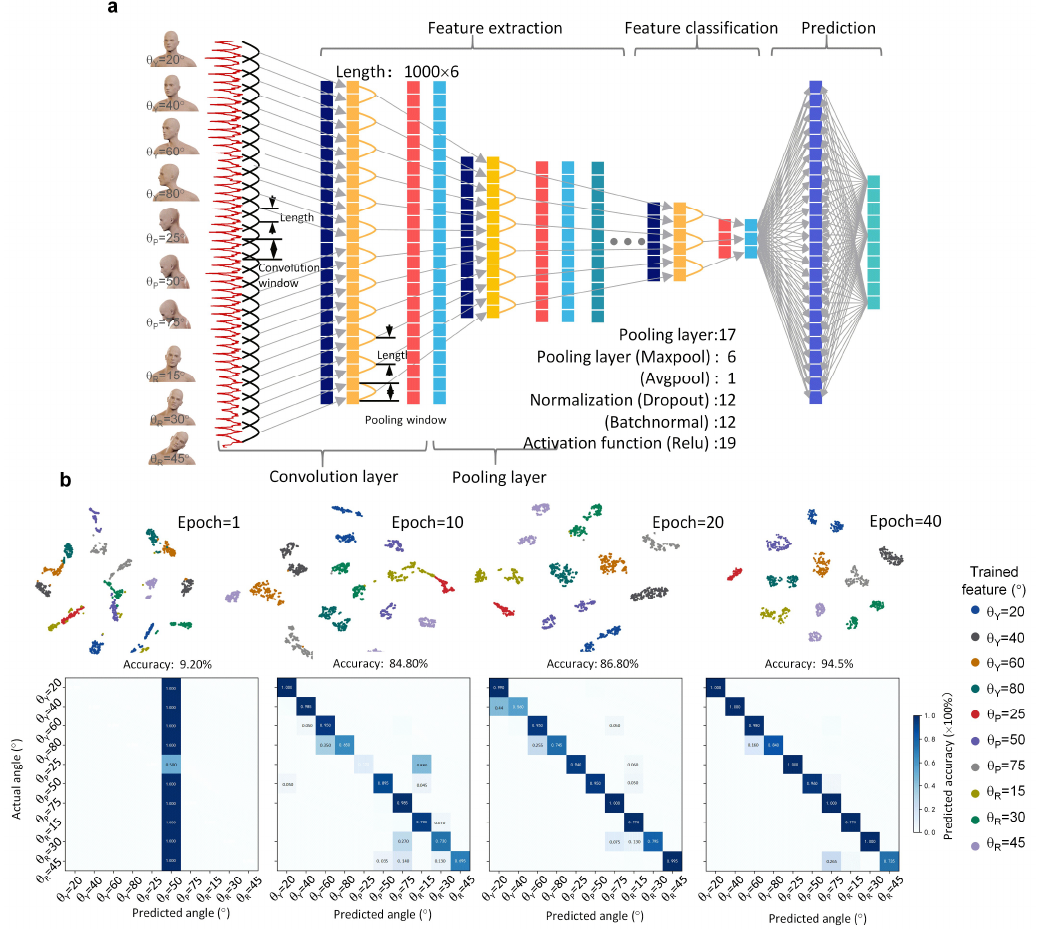
Figure 4. Machine learning for head posture recognition. ( a ) 2D CNN-based machine learning method. ( b ) Visualization cluster of the training via t-SNE (top) and the corresponding confusion matrix from the initial to the 40th epoch (bottom).